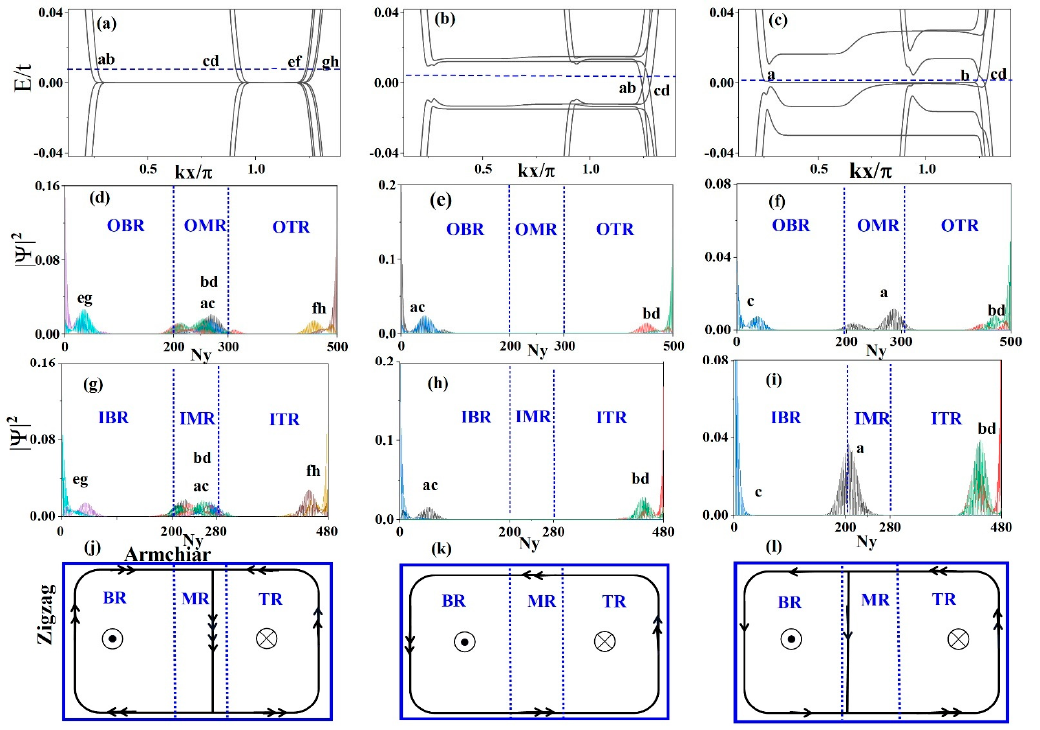
Figure 2. Top panels: Band structure of ZBBGN with ∅ = 0.002 for ( a ) E = 0, V 1 = − V 2 = 0; ( b ) E = 8.8 × 10 6 V/m, V 1 = − V 2 = 0; and ( c ) E = 0, V 1 = − V 2 = 0.02t. The Fermi energy is represented by the blue dashed lines hereafter. ( d – f ) Second panels: the probability density distributions of edge and interface states of the outer layer indicated by letters in top panels ( a – c ) versus the longitudinal position index Ny. ( g – i ) Third panels: the probability density distributions of edge and interface states of the inner layer indicated by letters in top panels ( a – c ) versus the longitudinal position index Ny. ( j – l ) Bottom panels: schematic diagrams of edge-state propagation (the direction indicated by arrows), corresponding to the edge states marked with letters in the top panels ( a – c